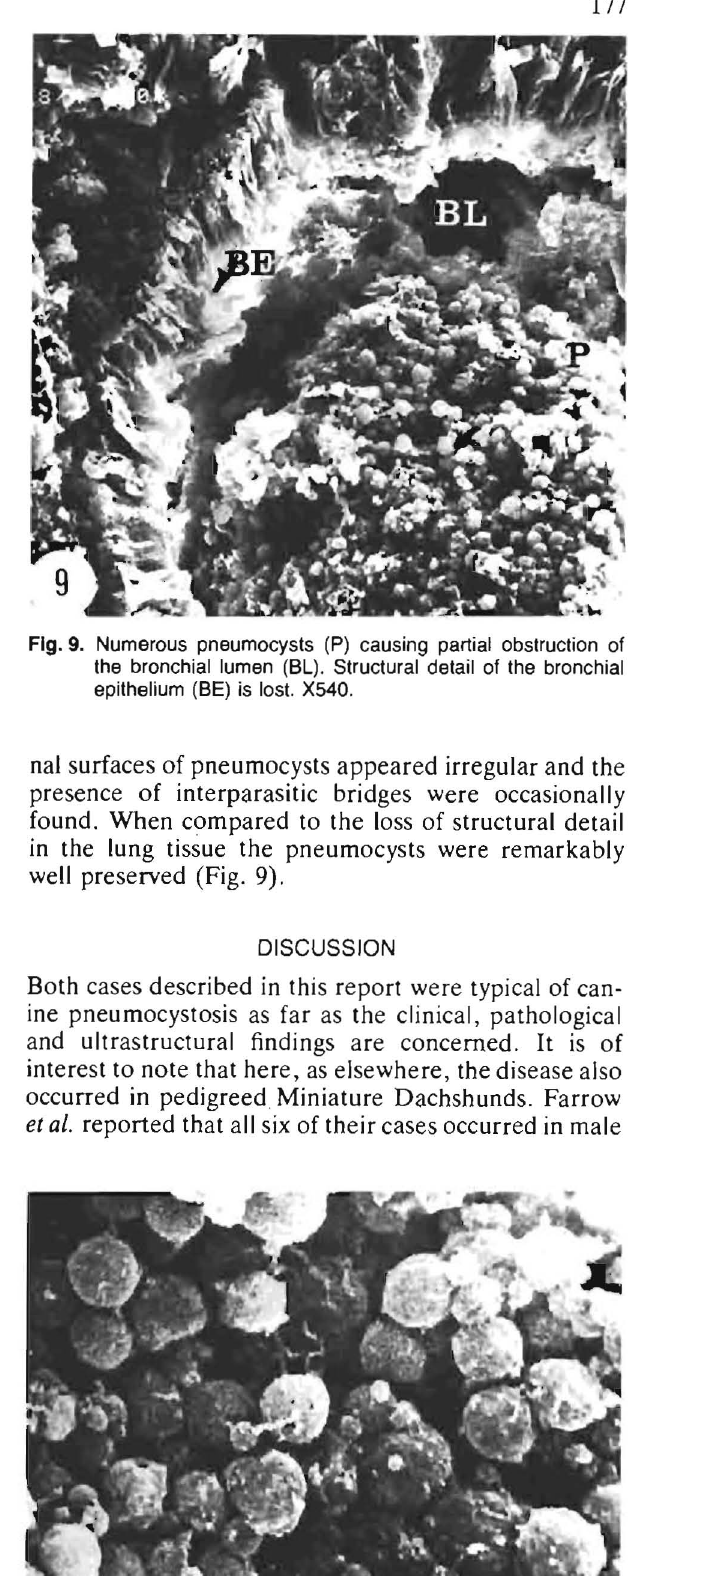
Fig. 8. Scanning electron micrograph of a small bronchus (B) in the lung of dog B. Note the plug that obstructs the lumen of the bronchus X40